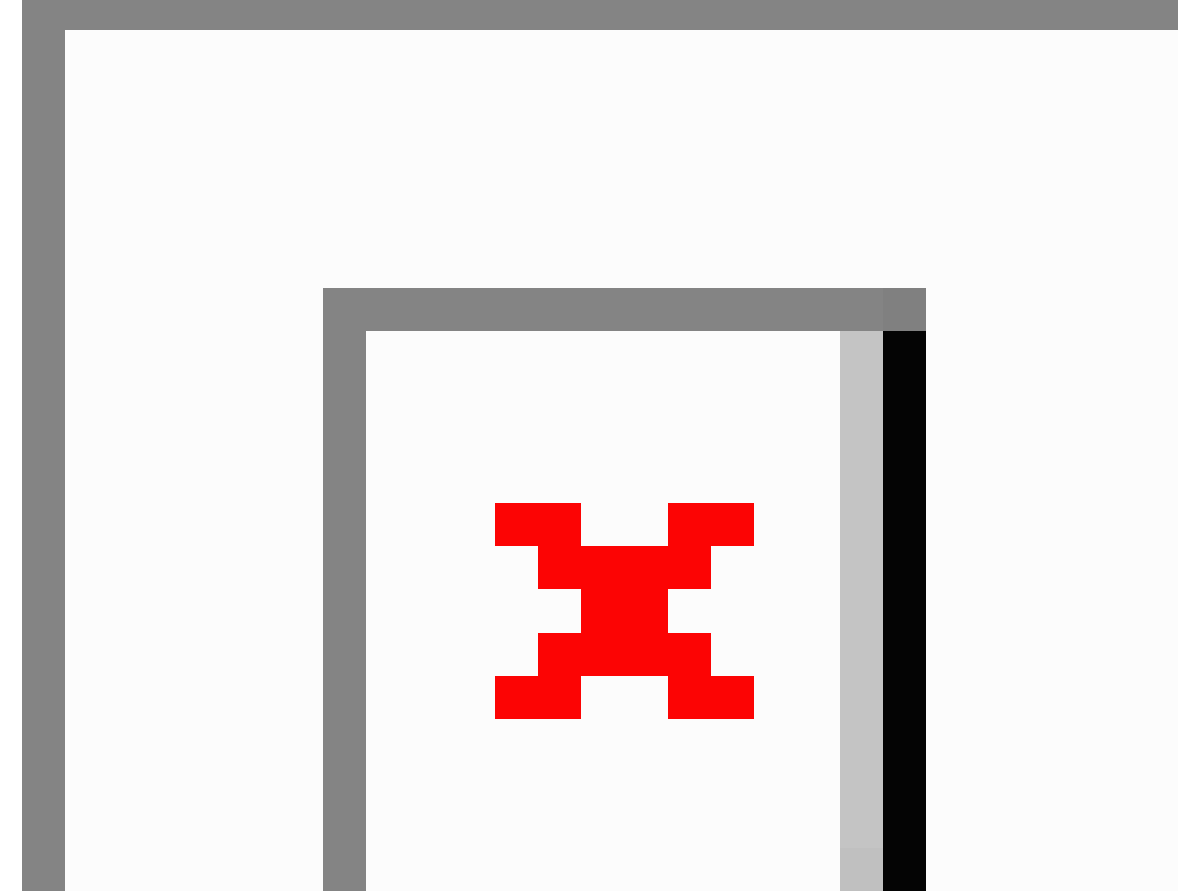
Figure 4. Aspect-based sentiment analysis results. x-axis: selected aspects; y-axis: number of positive occurrences and number of negative occurrences in log